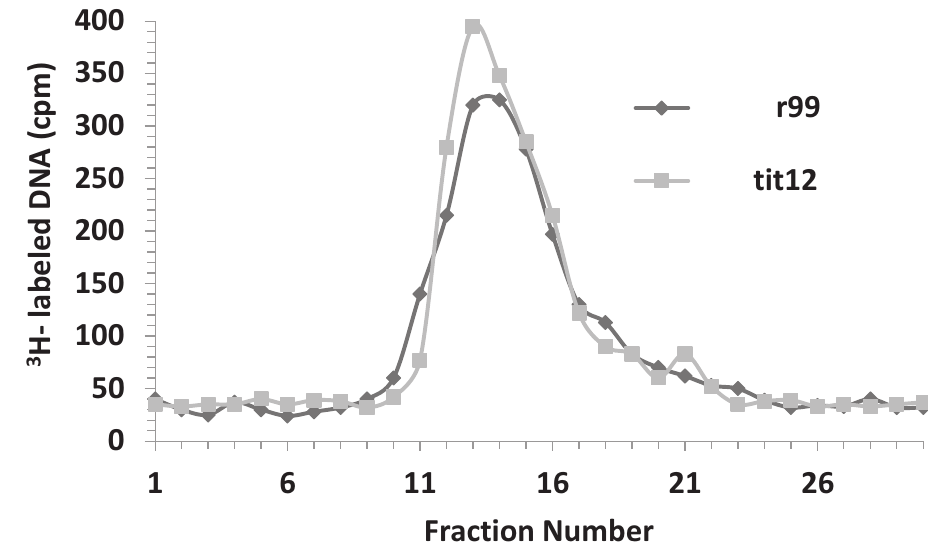
Figure 9. DNA fractionation after a second CsCl equilibrium density centrifugation of intracellular 3 H-labeled λ DNA isolated from infected HBT(pOrir99) or HB T(pOriti12). The density profile of intracellular λ DNA was obtained as described in Figure 7. Note that the profiles obtained from both of the infected strains are indistinguishable from each